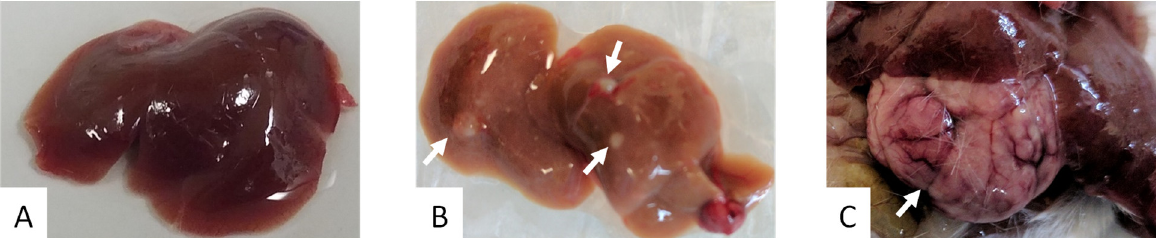
Figure 1. Typical appearance of the three groups of liver tissues under investigation. ( A ) A healthy mouse liver. ( B ) A heterogeneously inflamed liver with small nodules ca. 0.5–1 mm in size (arrows) and a cirrhotic gross appearance. ( C ) A HCC tumor (arrow) in the liver. ( B ) and ( C ) were obtained from aged MDR2-KO mice.